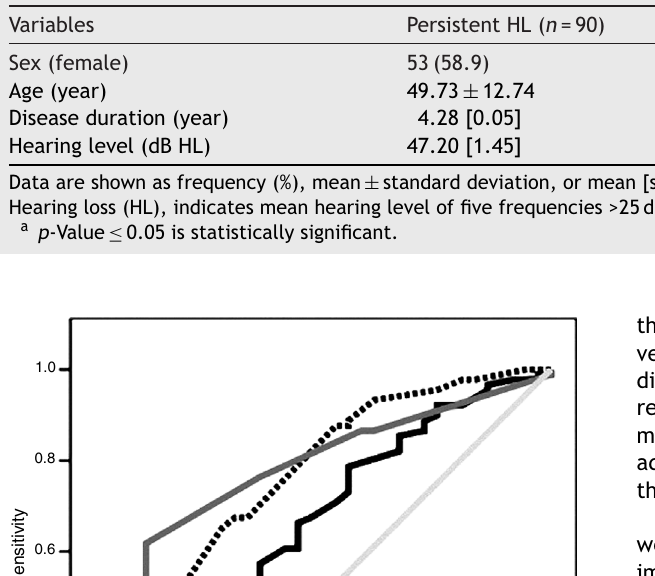
Table 2 Study variables in patients with persistent and resolved hearing loss (HL) six months after treatment.